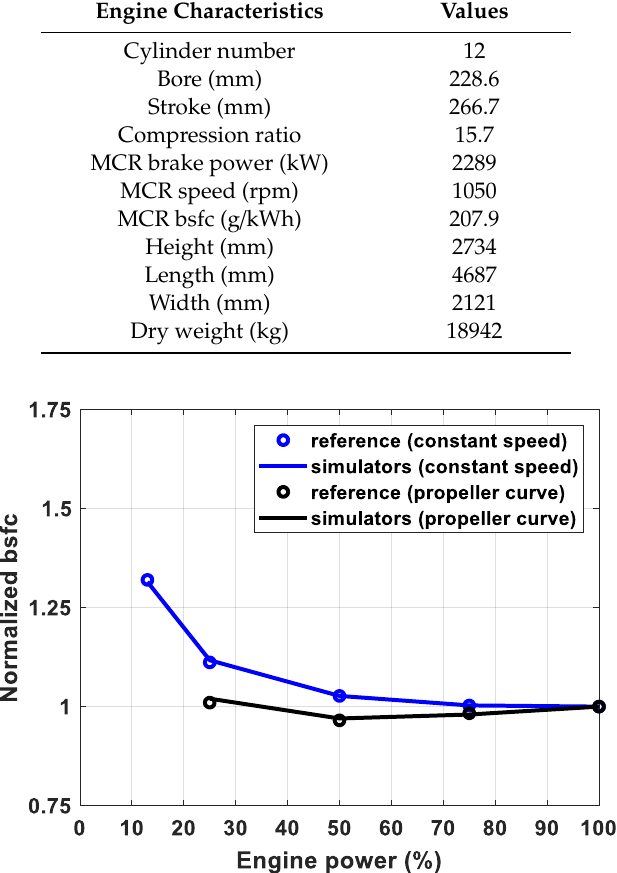
Figure 3. Brake specific fuel consumption comparison among reference data, engine actual cycle and 5-D matrices “cylinders” simulation results.